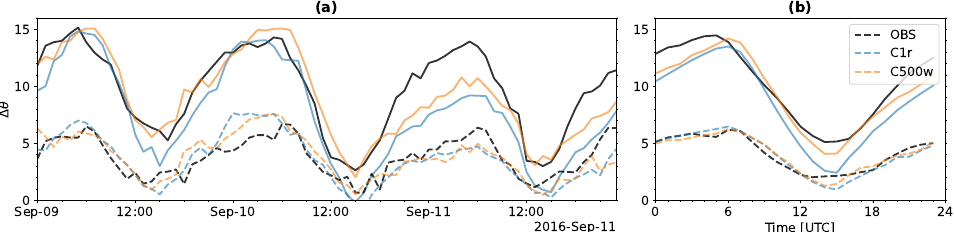
Figure 14. Comparison of observed and simulated bulk stratification of the valley atmosphere, based on observed and simulated temperature at the stations Sion (482 m MSL), Montana (1427 m MSL), and Les Diablerets (2964 m MSL). Stratification over the entire valley depth is given by the potential temperature difference between Les Diablerets and Sion (solid curves); stratification of the lower part of the valley depth is given by the difference between Montana and Sion. ( a ) Time series of the stratification for the period 9–11 September 2016; ( b ) mean diurnal cycle of the stratification for the valley wind